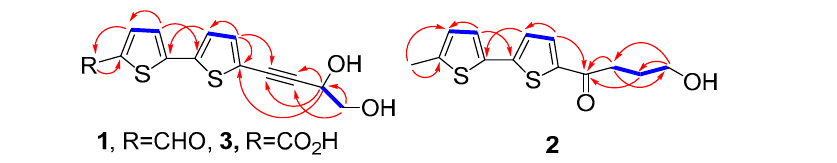
Figure 2. 1 H, 1 H-COSY and key correlations in HMBC spectra (H C) of compounds